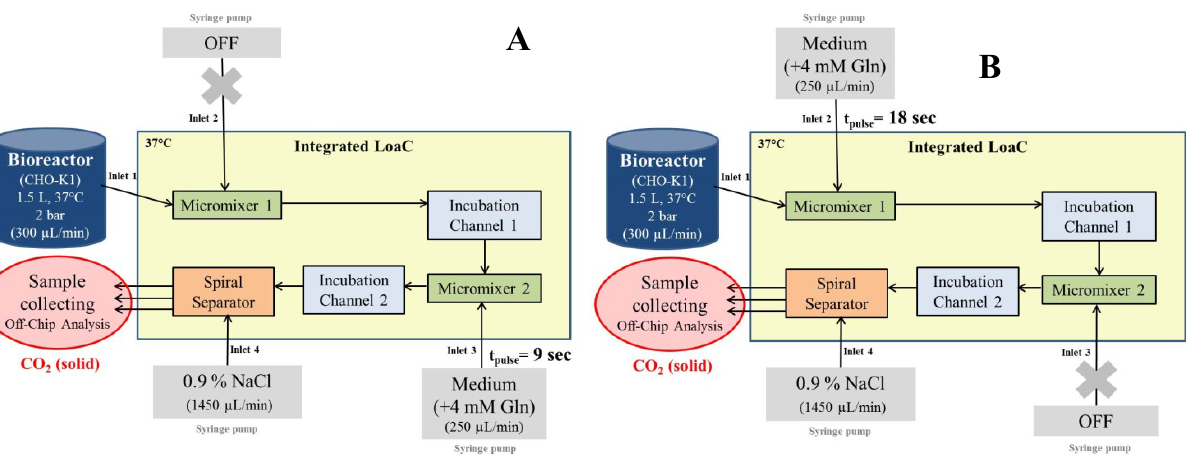
Figure 5. Schematic of the experimental setup for glutamine pulse experiments. ( A ) Experimental setup for a 9 sec pulse. Here, the syringe pump at Inlet 2 is switched off while the pump at Inlet 3 is operating. ( B ) Experimental setup for an 18 sec pulse. Here, the syringe pump at Inlet 2 is operating while the pump at Inlet 3 is switched off.